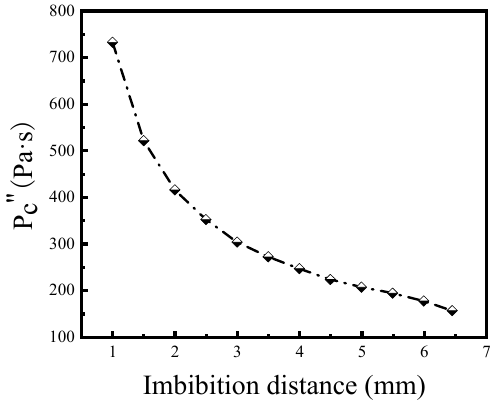
Figure A3. The curve of 𝑃 (cid:3030)(cid:4593)(cid:4593) as a function of imbibition distance. The figure above shows that 𝑃 (cid:3030)(cid:4593)(cid:4593) has a linear relationship with the square root of imbibition distance ( L ), and 𝑃 (cid:3030)(cid:4593)(cid:4593) decreases with the increase of imbibition distance, so the characteristic parameter a in Equation (8) is negative. According to the similarity between 𝑃 (cid:3030)(cid:4593) and 𝑃 (cid:3030)(cid:4593)(cid:4593) , the characteristic parameter n in Equation (8) is determined to be 0.5. Expression (8) and Expression (9) become the following expression as shown in Equa- tions (A5) and (A6):